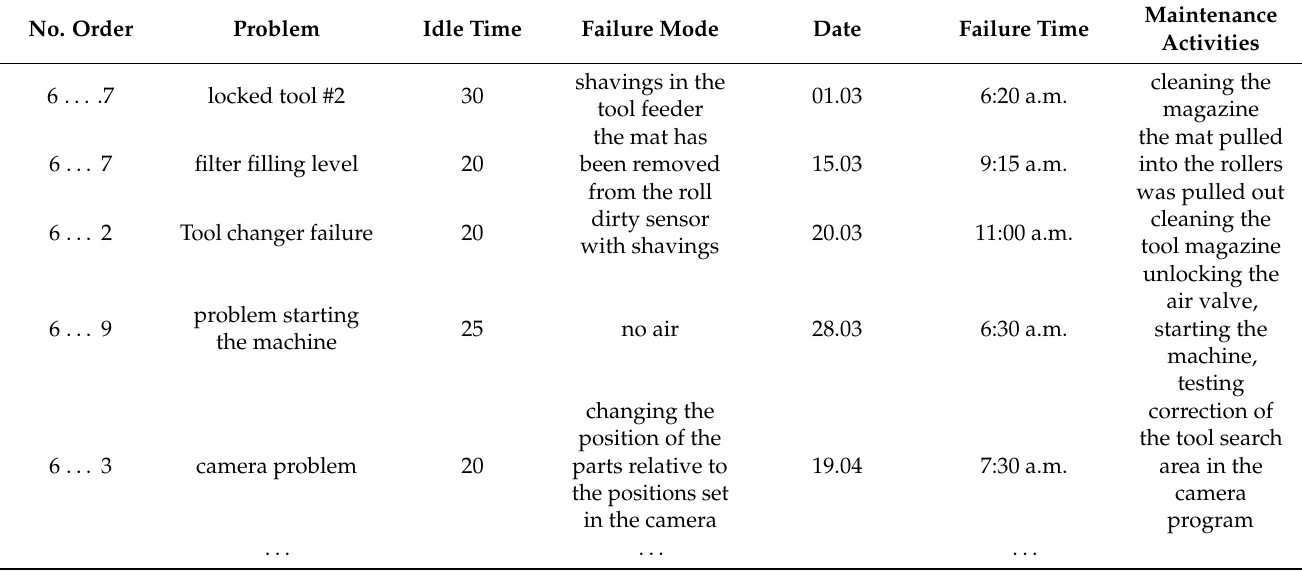
Table 1. Washing machine maintenance data